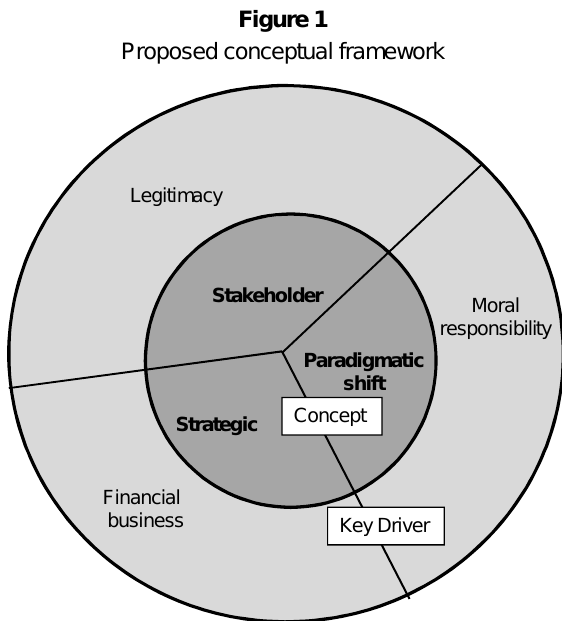
Proposed conceptual framework